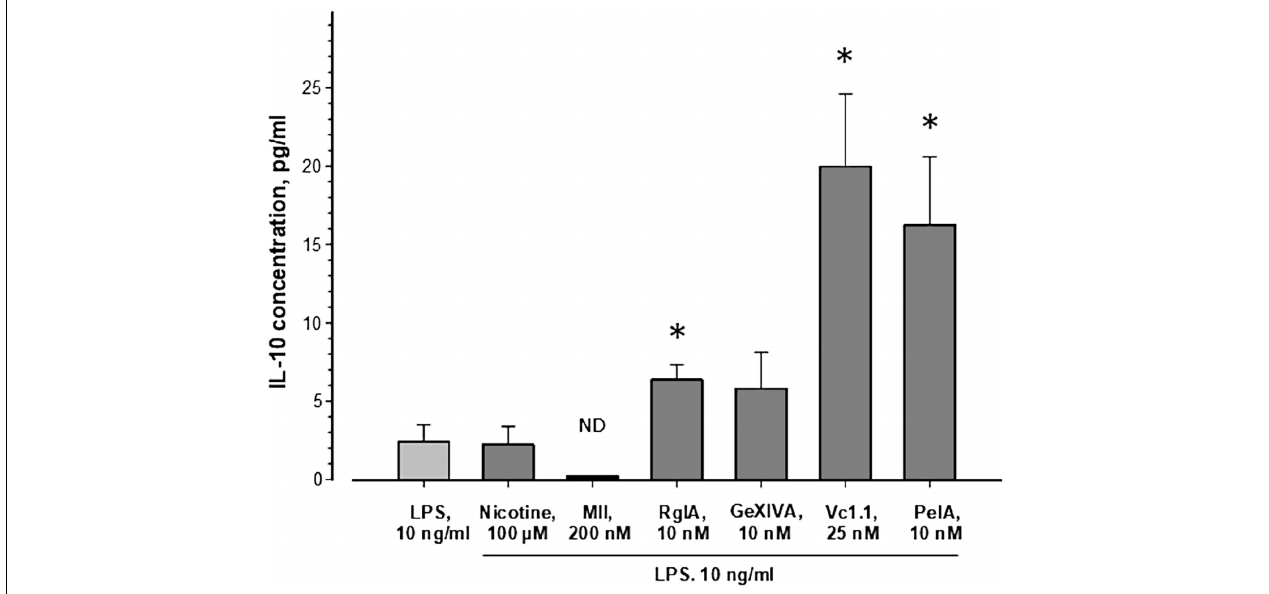
FIGURE 1 | Influence of nAChR ligands on the release of IL-10 from murine bone marrow granulocytes. Cells were incubated in a medium containing 10 ng/ml lipopolysaccharide from E. coli without or with nicotine or α -conotoxins, as indicated. IL-10 concentrations were measured in supernatants after 23 h of cell incubation using a mouse IL-10 ELISA kit (ab108870, Abcam, United Kingdom). The average values ± SEM of 9–12 independent measurements, each performed in duplicates, are shown. The Kruskal-Wallis One Way Analysis of Variance on Ranks and the Mann-Whitney Rank Sum Test were used. ND, not detectable; ∗ p < 0.05 compared to the cells treated with LPS